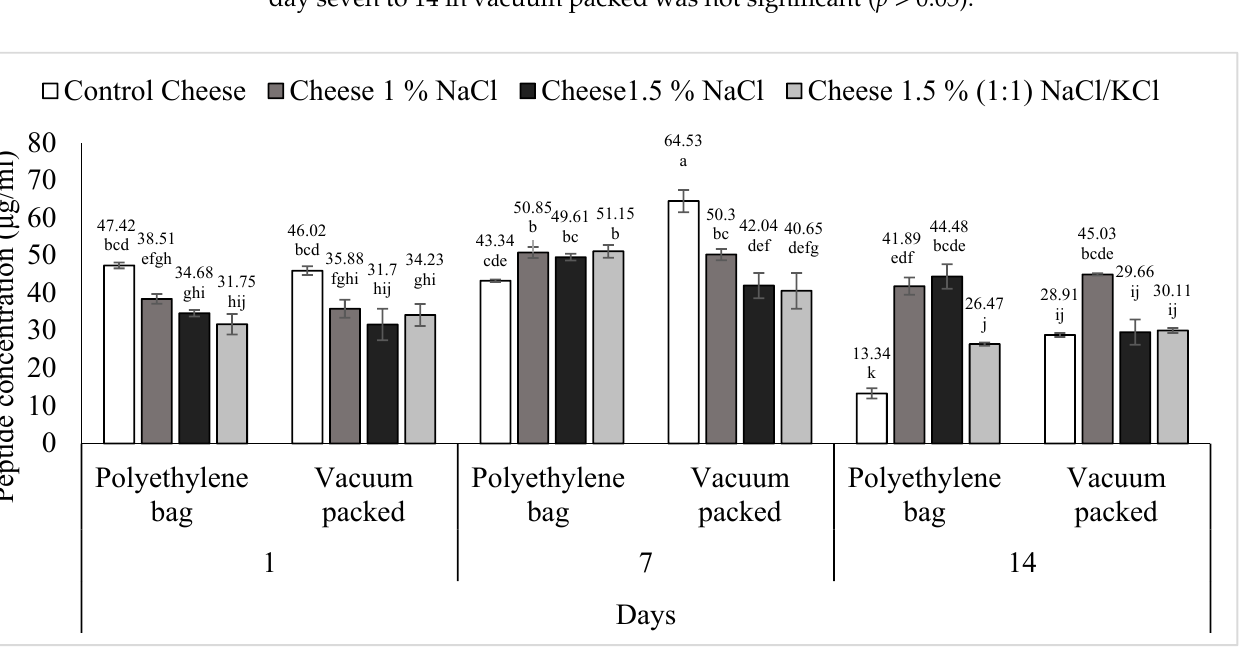
Figure 4. Peptide concentration of requeson cheese with different salt type and concentration treatments, conventional and vacuum packaging. a–k Values with a different superscript indicate significant statistical difference ( p < 0.05).